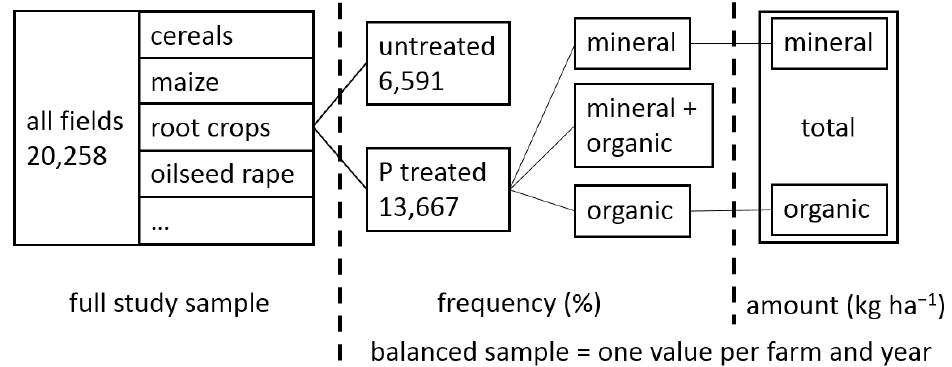
Figure 2. Structure and terminology of P use data analysed in this study.